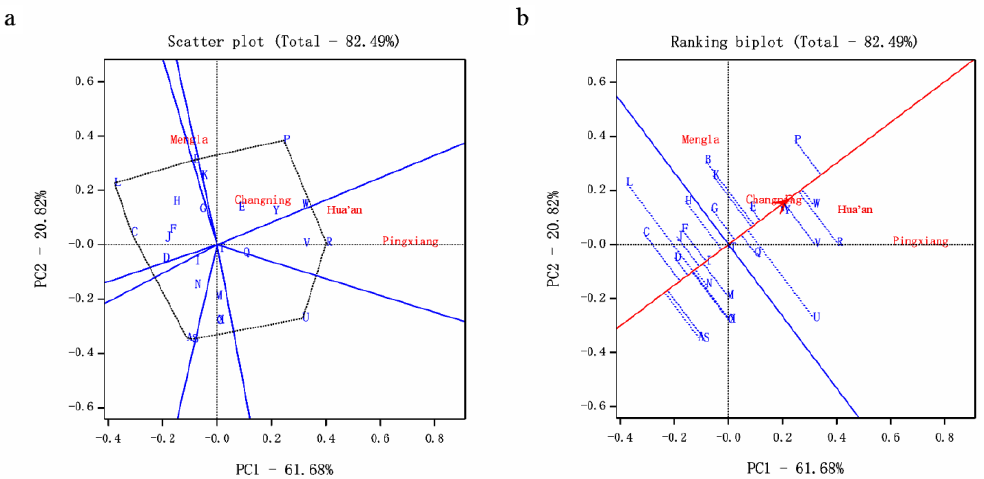
Figure 1. Biplot analysis based on diameter at breast height (DBH) data of 25 provenances. ( a ) Polygon view of genotype by environment (G × E) interaction (GGE) biplot—which is best for what, ( b ) genotypes of ranking provenances. A, Mengla; B, Yuanyang; C, Mojiang; D, Jinghong; E, Xichou; F, Zhenyuan;